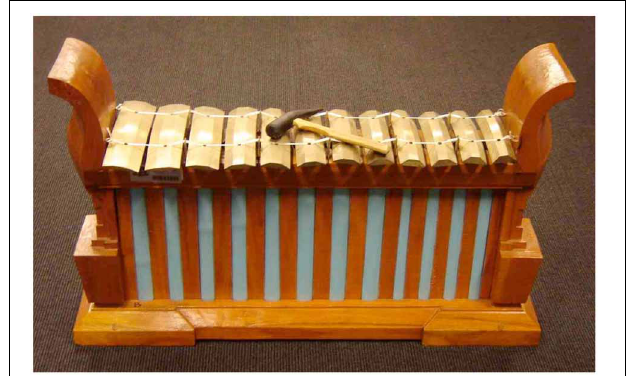
FIGURE 2 | Gangsa instrument. Photo: Peter